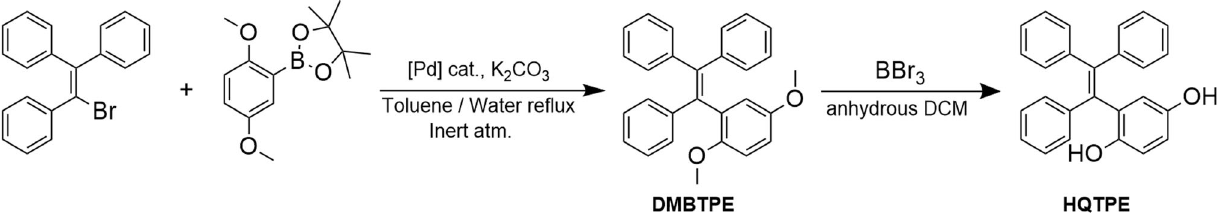
Fig. 2 Synthesis of 1-(2,5-dimethoxyphenyl)-1,2,2-triphenylethene (DMBTPE) and 1-hydroquinol-1,2,2-triphenylethene (HQTPE). HQTPE could be synthesized by Suzuki – Miyaura coupling and demethylation with a satisfactory yield.